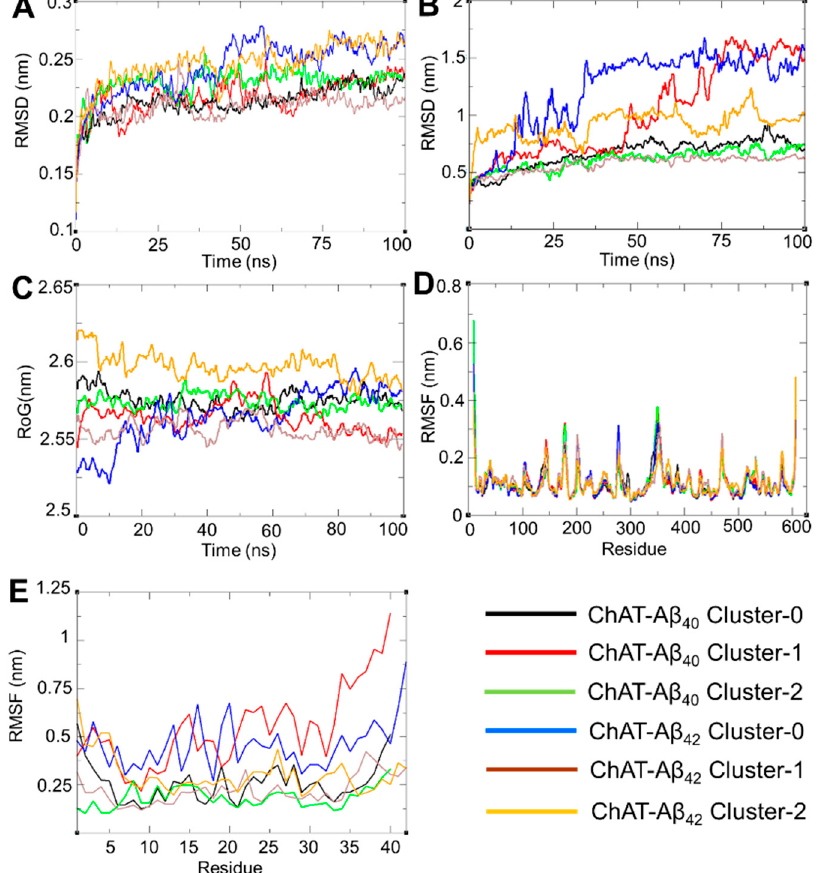
Figure 3. Molecular dynamics simulation analyses support the potential interaction and stability between A β peptides and ChAT. ( A ) represents root mean squared deviation (RMSD) plots as a function of simulation period for the ChAT protein. ( B ) shows the root mean squared deviation (RMSD) plots for A β peptides. ( C ) illustrates the radius of gyration (RoG) plots for the complexes. ( D , E ) show root mean squared fluctuation (RMSF) for ChAT and A β amino acid residues, respectively. The clusters are represented by the given color scheme. All of the graphs were plotted with the QtGrace software package.